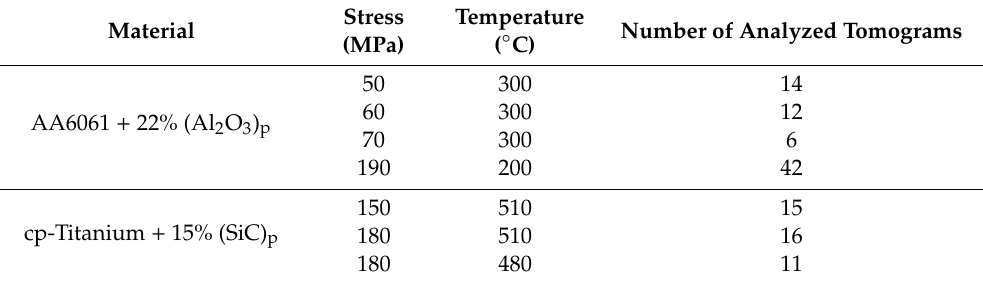
Table 2. Creep loading and number of tomograms.